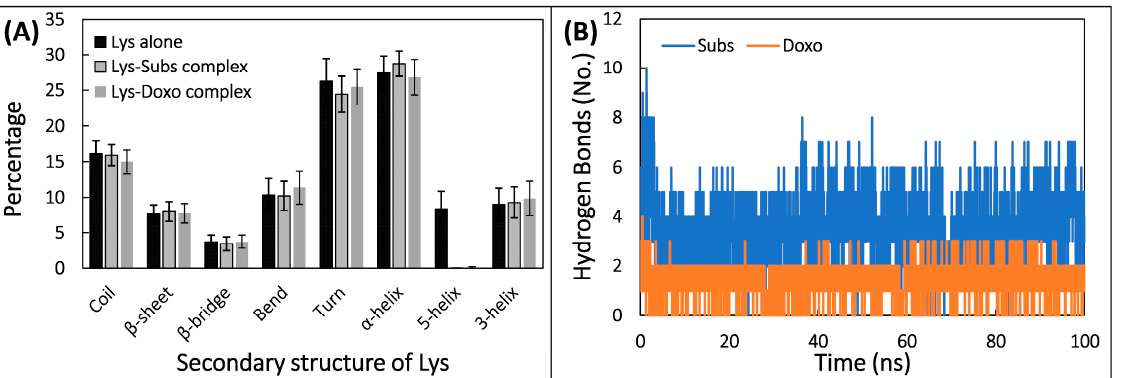
Figure 8. ( A ) Average percentage of secondary structure in lysozyme in the absence and presence of substrate and doxofylline. ( B ) Number of hydrogen bonds formed by substrate/doxofylline with lysozyme as a function of simulation time.